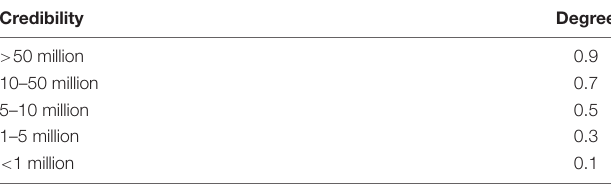
TABLE 1 | The assigned degree of credibility of rumour control centre (CR).